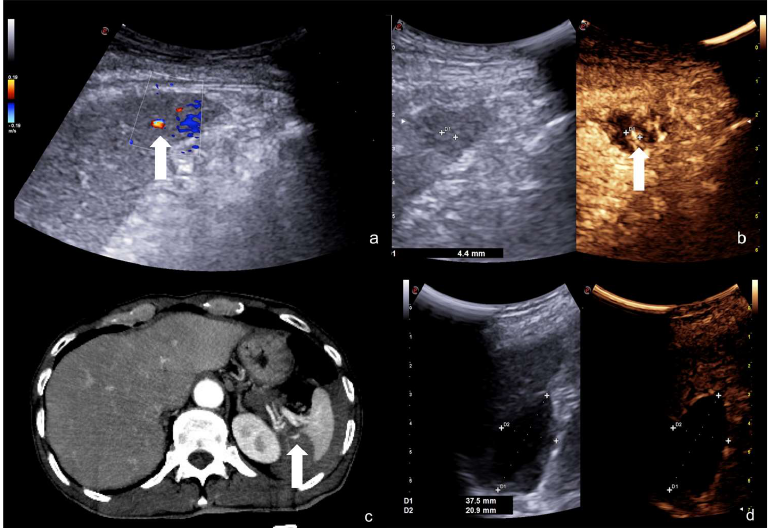
Figure 24. An example of multimodal visualization of post-traumatic splenic PSA (white arrows) at CD–US ( a ), CEUS ( b ), and arterial phase contrast-enhanced CT scan ( c ); CEUS follow-up examination after embolization (d) showed no evidence of residual PSA.